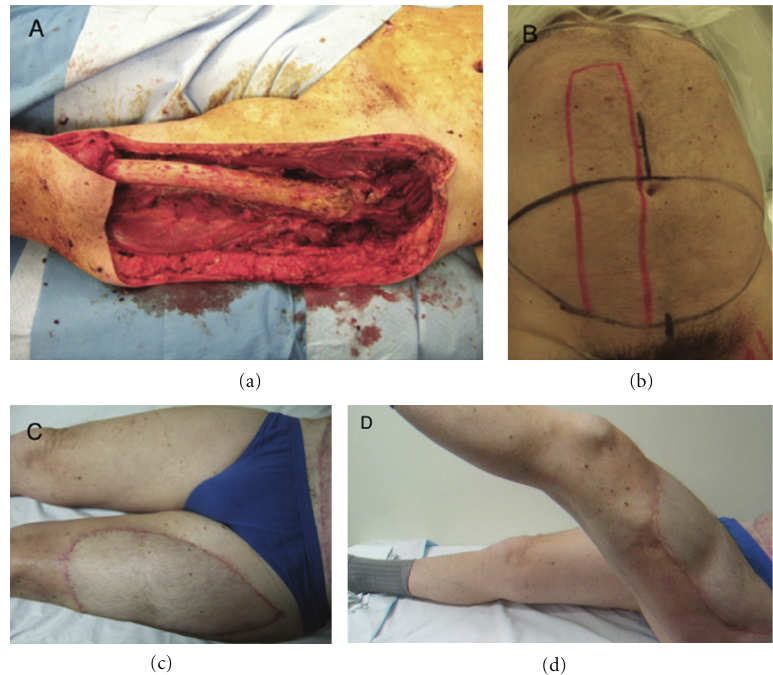
Figure 2: Patient treated for high-grade pleomorphic sarcoma of the anterior compartment of the thigh. (a) Intraoperative image. The resection involved the entire quadriceps compartment and measured 35 × 14 × 25cm. (b) The reconstruction was performed using innervated TRAM. (c, d) At 24 months postoperatively, the patient demonstrated full extension of the knee, flexion limited to 100 degrees, and muscle strength of